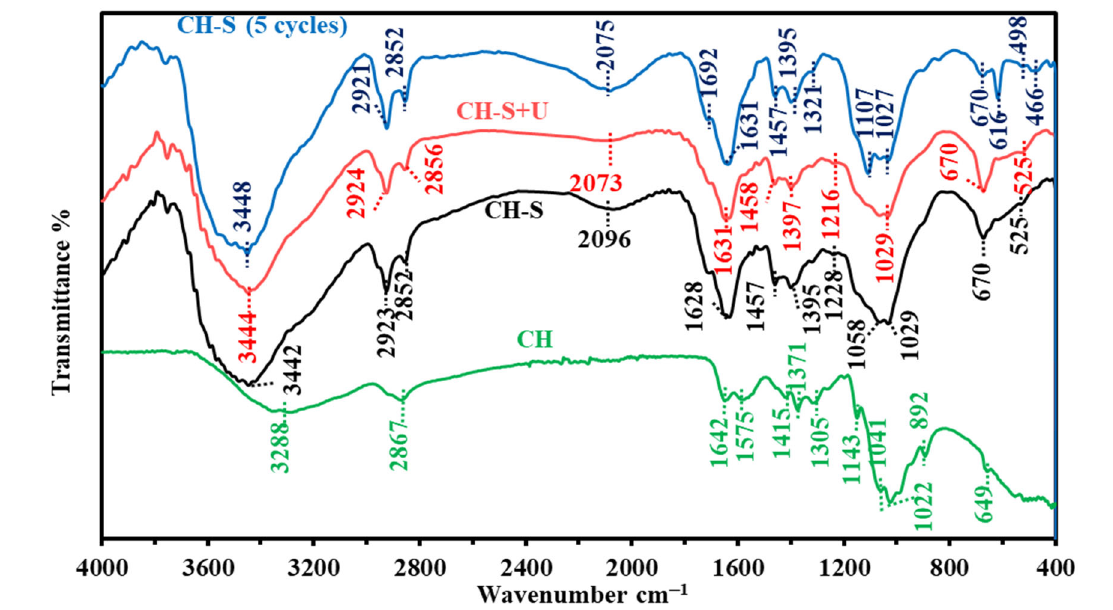
Figure 3. FTIR spectra of CH, CH-S, after loading and after 5 cycles of sorption desorption process (full wavenumber). Table 2. Assignments peaks in FTIR spectra for CH and CH-S (before and after U(VI) sorption, and after five cycles of sorption and